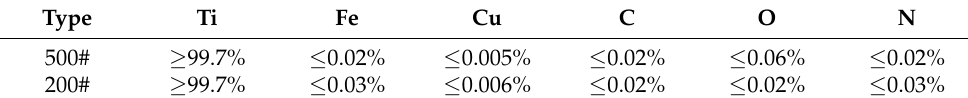
Table 1. Chemical composition of titanium powder (wt %).